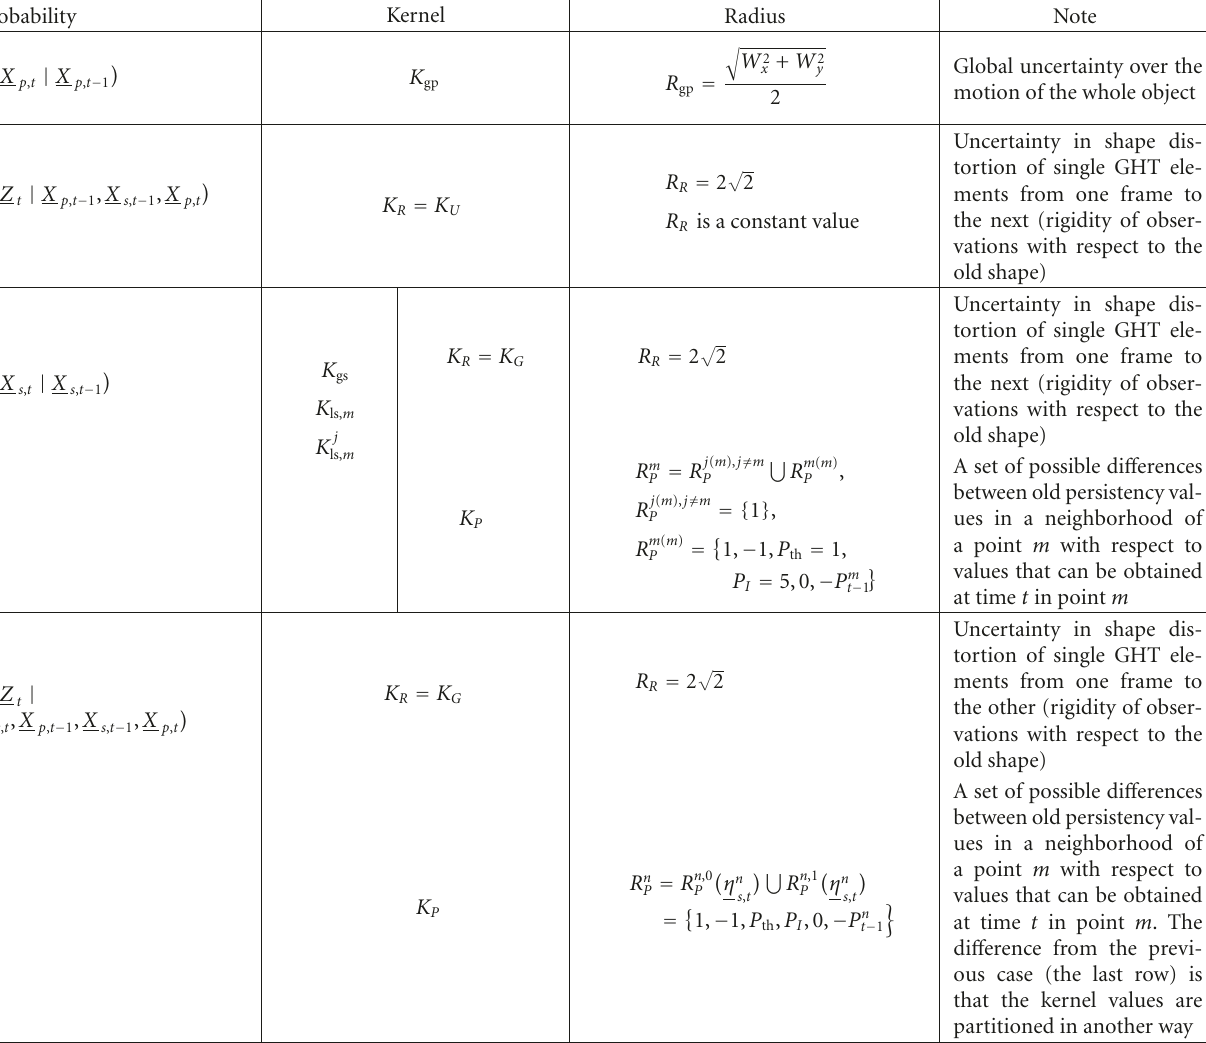
Table 3: Kernels that have been used in the implemented algorithms (described in the next sections) to estimate di ff erent probabilities in (6) and (21), along with the related probability terms, related kernel radii, and a short explanation about the e ff ect of each kernel on the model. Probability Kernel Radius Note